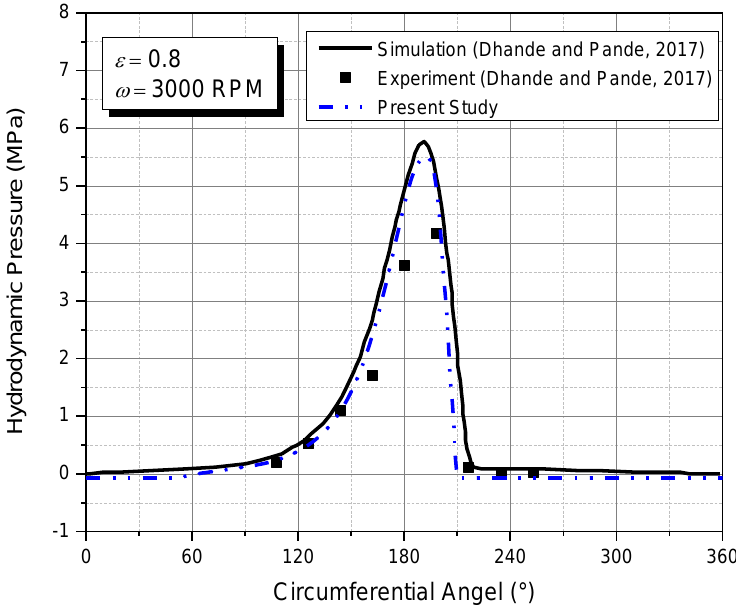
Figure 5. Comparison of hydrodynamic pressure between the result of the present study and the reference [33]. The numerical results are evaluated at mid-plane z/ L of 0.5, rotational speed of 3000 rpm, and eccentricity ratio ε of 0.8.